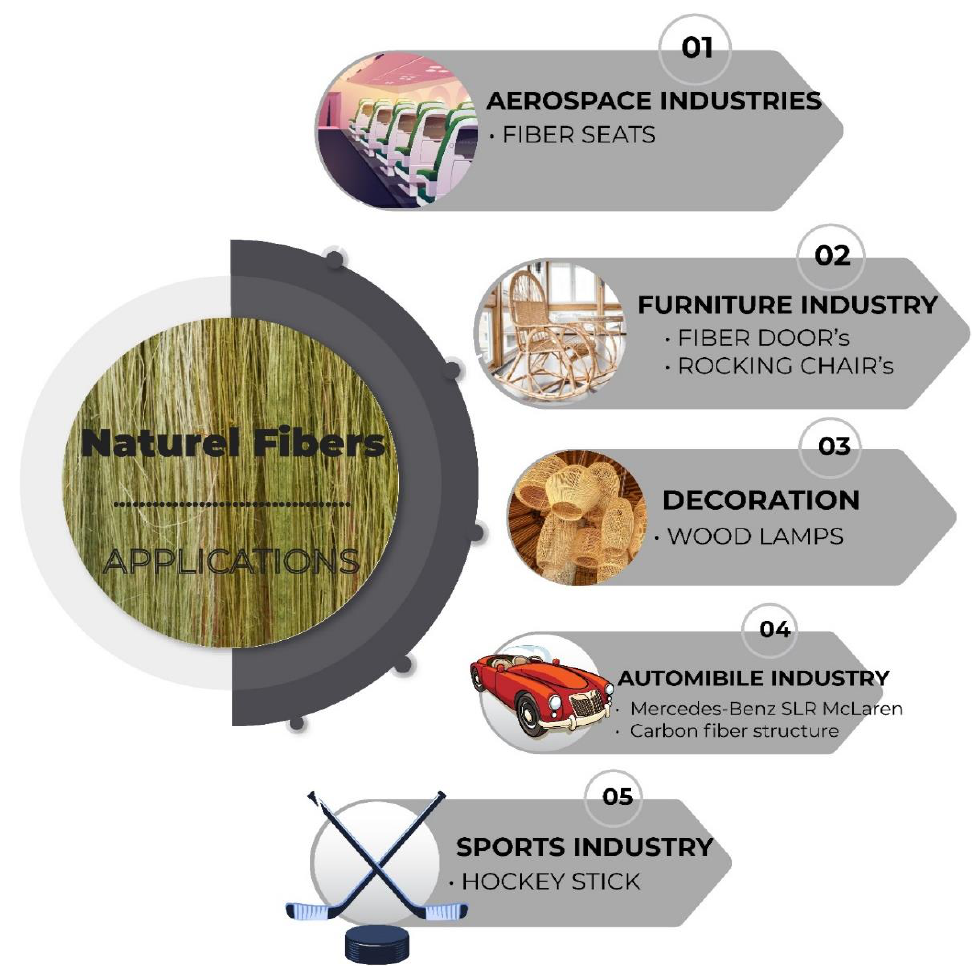
Figure 7. General applications of natural fibers.